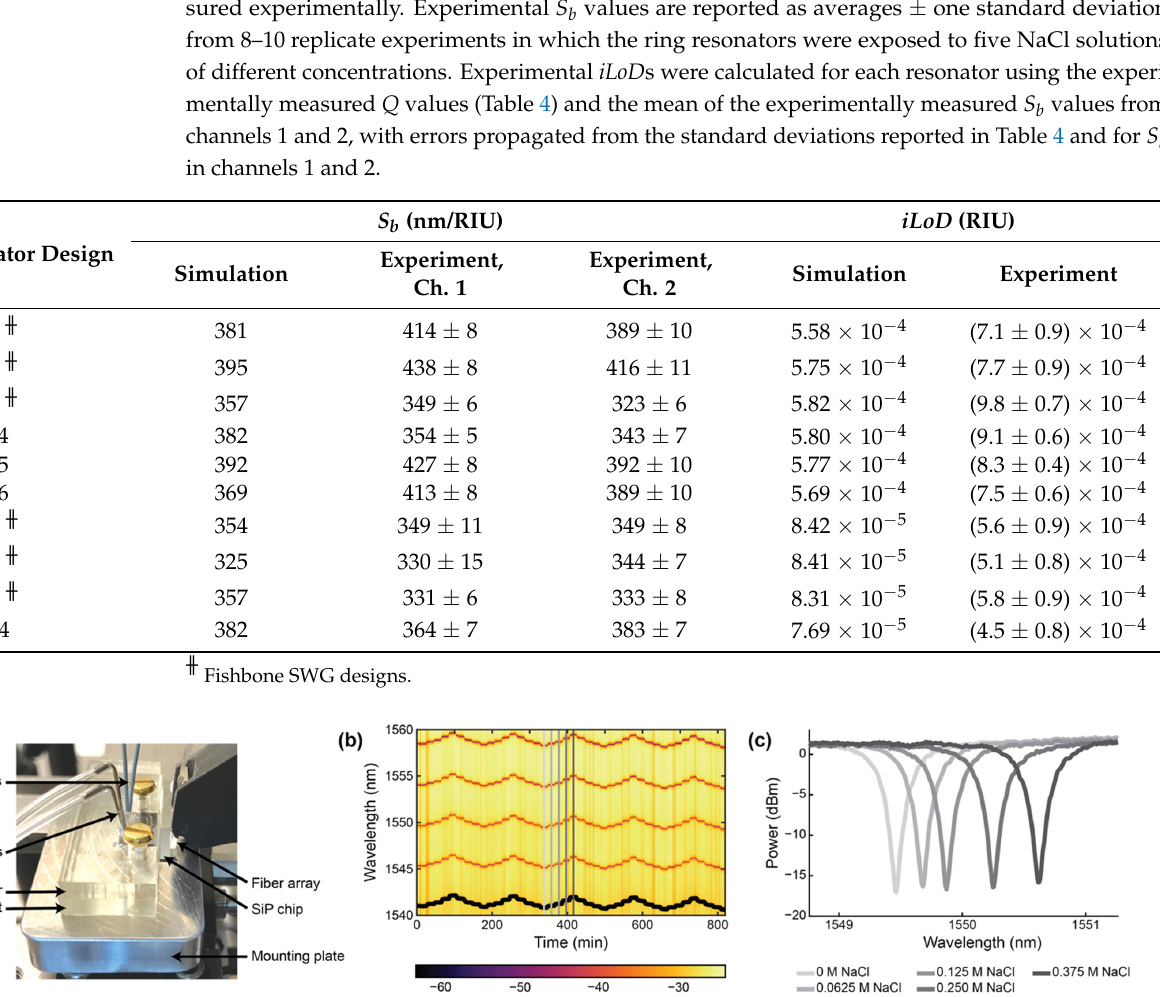
Figure 10. ( a ) Measurement setup for bulk sensitivity experiments, showing a SiP sensor chip interfaced with microfluidics and coupled to a fiber array to connect to benchtop optical inputs and outputs. ( b ) Spectrogram with overlaid peak tracking plot (black line) for device C3 measured during a bulk sensitivity experiment in which the sensor was exposed to five different NaCl solutions, each with different concentrations, a total of ten times. ( c ) Overlaid spectra for device C3 illustrating the red shift in resonance peak wavelength with increasing NaCl concentration. The vertical gray lines in ( b ) indicate the times at which the spectra displayed in ( c ) were obtained during the bulk sensitivity experiment.